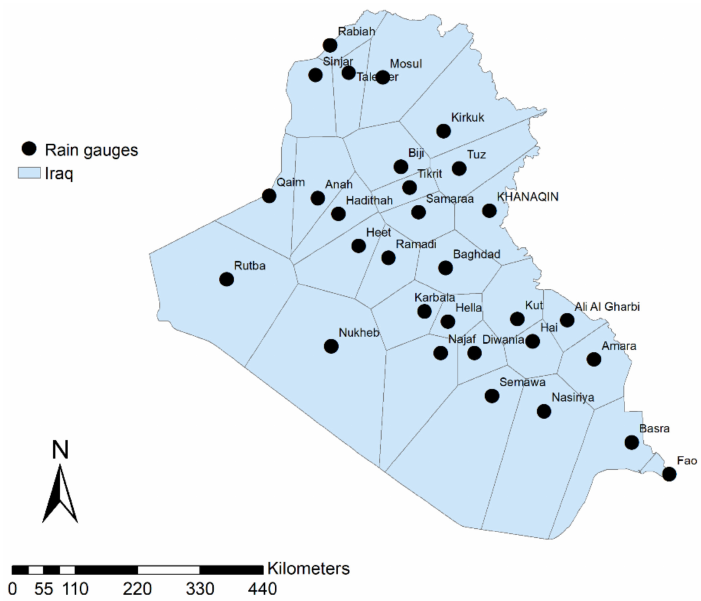
Figure 4. Thiessen polygon for calculating the areal precipitation in Iraq.